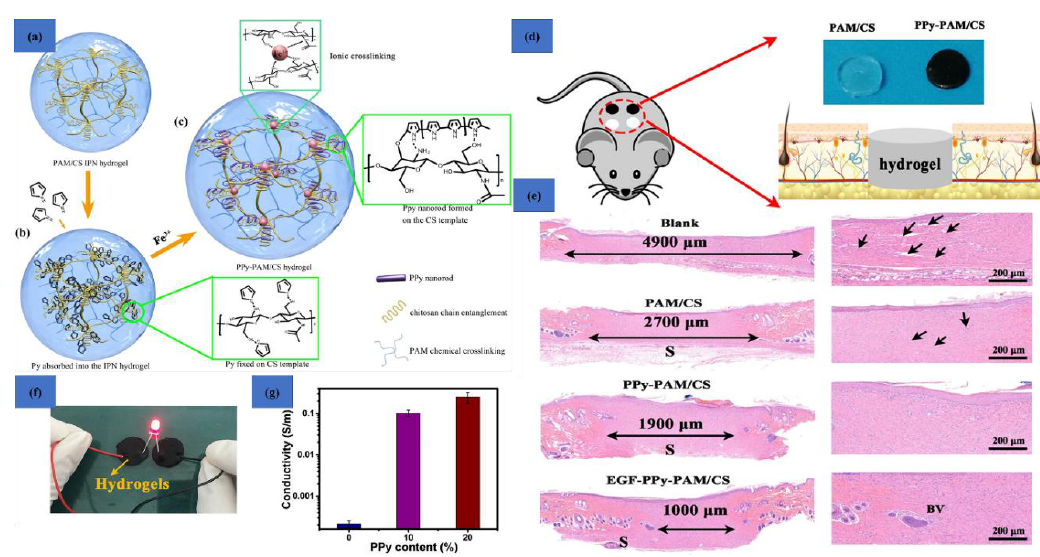
Figure 14. ( a ) Synthesis of polyacrylamide/chitosan (PAM/CS) interpenetrating (PAM/CS IPN) hydrogels; ( b ) polypyrrole was absorbed into the IPN hydrogel, fixed on CS chains, and accumulated in the zone of CS entanglement; ( c ) polypyrrole (PPy) was polymerized in situ in the hydrogel under the controlling of CS molecular templates; PPy-conductive pathway (purple line) intertwisted along CS chains (purple line), and PPy nanorods aggregated on the chain entanglement zone of CS hydrogels for repairing full thickness defects on rats. ( d ) Schematics of hydrogel implantation and conductive properties of the hydrogel. ( e ) H&E (histomorphological evaluation) staining of wound sections after 21 days; S, sample; BV, blood vessel. ( f ) PPy–PAM/CS hydrogel was connected to a circuit and illuminated an LED; ( g ) conductivity of the PPy–PAM/CS hydrogel with different contents of PPy [151] .